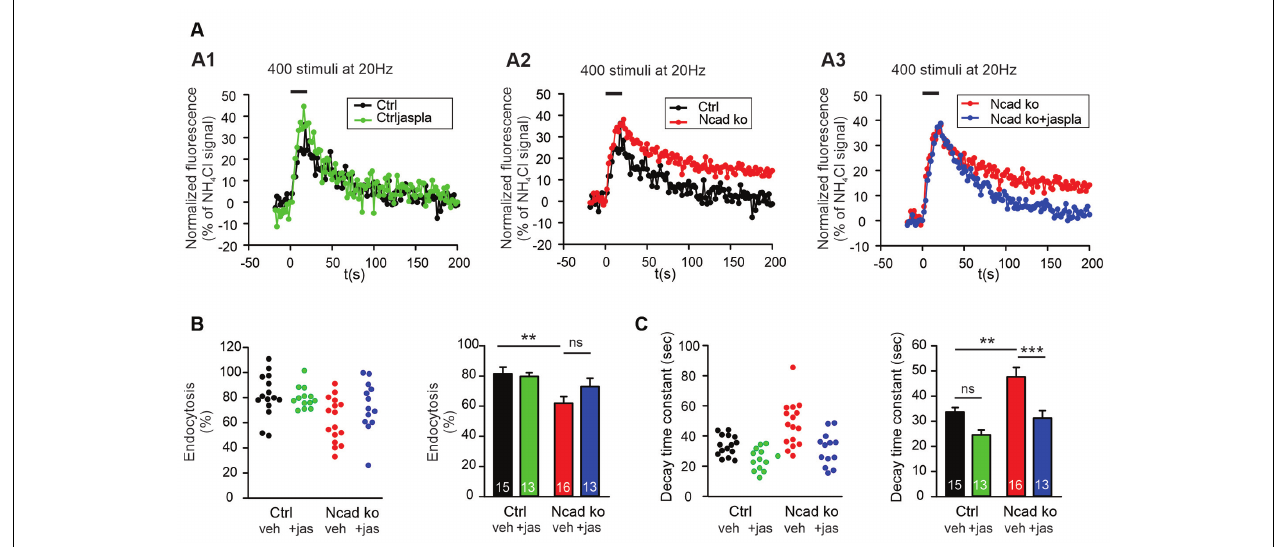
FIGURE 6 | Polymerization of actin induced by Jasplakinolide in N-cadherin knockout neurons ameliorated impaired synaptic vesicle endocytosis. (A–C) SypHy imaging was performed at autapses (400 stimuli at 20 Hz at 34 ◦ C) in control and N-cadherin knockout neurons at 14–15 DIV (see Figure 1 ). Cultures were treated with 5 µ M Jasplakinolide for 5 min before imaging to induce actin polymerization. (A1) Example time courses of mean SypHy fluorescence intensities (all puncta per cell averaged, normalized to NH 4 Cl signal) for control neurons (co-expressing DsRed2 + SypHy; black) and control neurons treated with 5 µ M Jasplakinolide (green). (A2) Example time courses of mean SypHy fluorescence intensities for control neurons (black) and N-cadherin knockout neurons (co-expressing DsRed2 + SypHy + CreEGFP, red). (A3) Example time courses of mean SypHy fluorescence intensities for N-cadherin knockout neurons (red) and N-cadherin knockout neurons treated with 5 µ M Jasplakinolide (blue). Note that SypHy traces for control (A1,A2) and N-cadherin knockout (A2,A3) neurons are shown twice for clarity. (B) Quantitative analysis of endocytosis at 90 s after the end of stimulation (SypHy signal loss as % of maximal SypHy signal) in individual neurons ( left ), and means ± SEM ( right ) for control neurons (black), control neurons treated with Jasplakinolide (green), N-cadherin knockout neurons (red), and N-cadherin knockout neurons treated with Jasplakinolide (blue). n = 15/13/16/13, total SypHy puncta analyzed were 341/382/430/311. P = 0.010 (ctrl vs. N-cad ko). (C) Quantification of SypHy signal decay time constant (tau, monoexponential fit) in individual neurons ( left ), and means ± SEM ( right ). P = 0.123 (ctrl vs. ctrl+jaspla); P = 0.003 (ctrl vs. N-cad ko); P < 0.001 (N-cad ko vs. N-cad ko + jaspla). Statistical analysis was done using one-way ANOVA with Tukey post hoc test, ns: non-significant, ** P < 0.01; *** P <